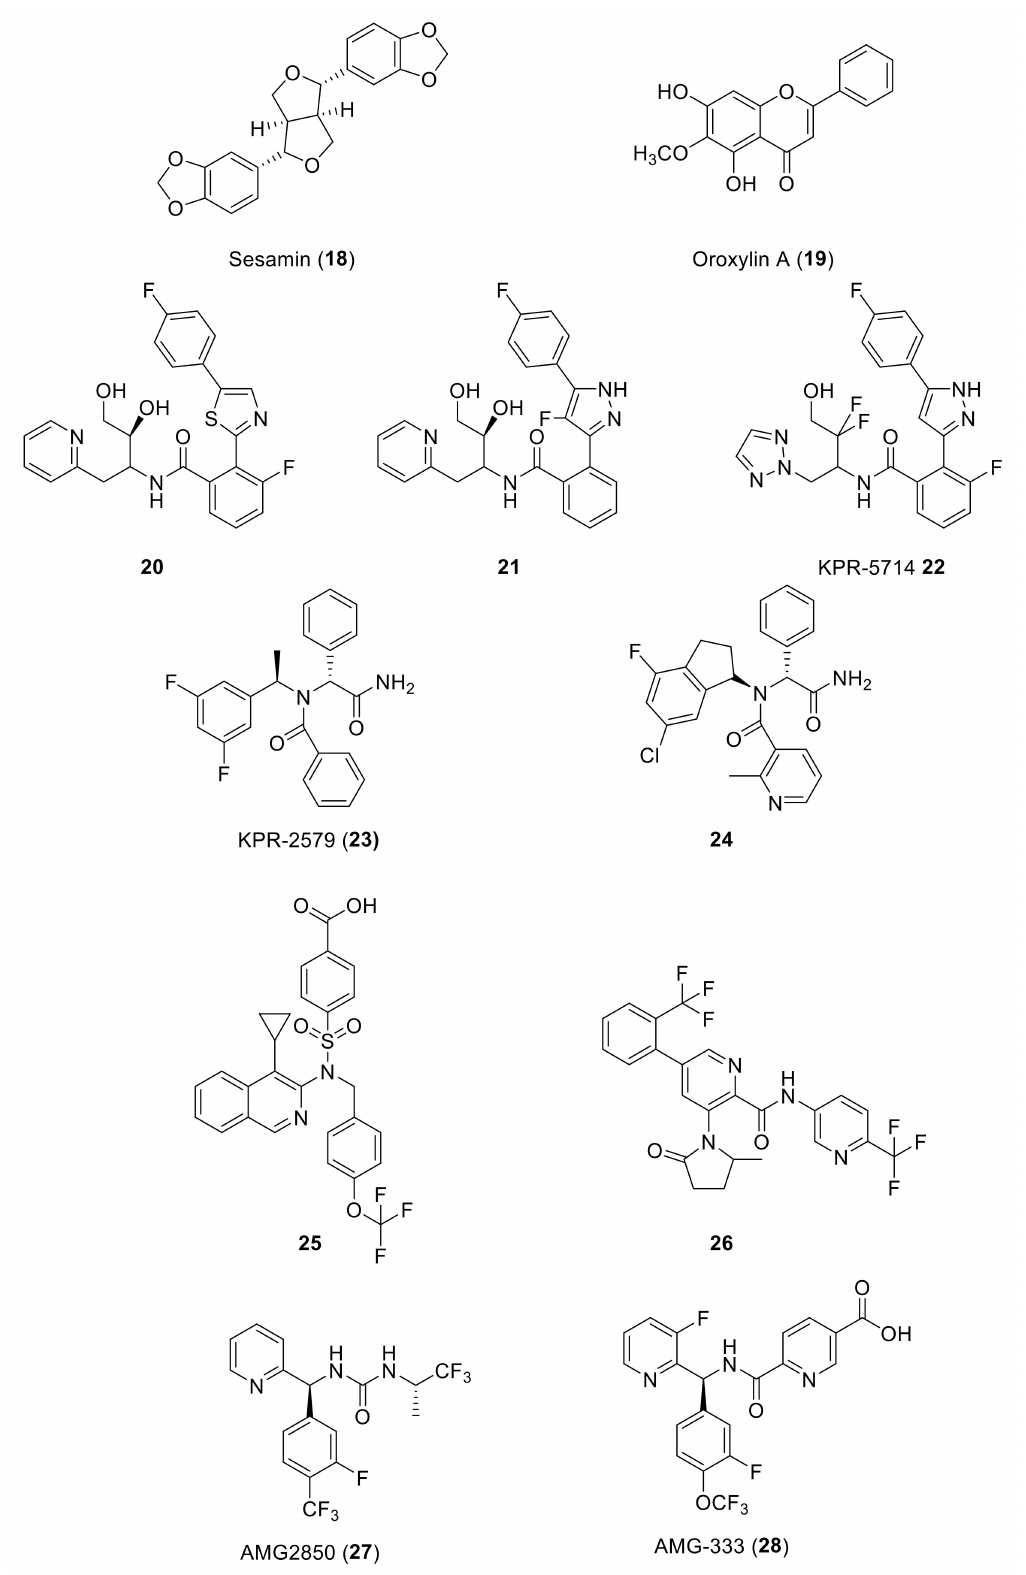
Figure 5. Novel TRPM8 antagonists derived from natural sources and pharmaceutical companies. The main source of TRPM8 antagonists are synthetic compounds, most of them identified and further optimized by pharmaceutical companies. Thus, KISSEI